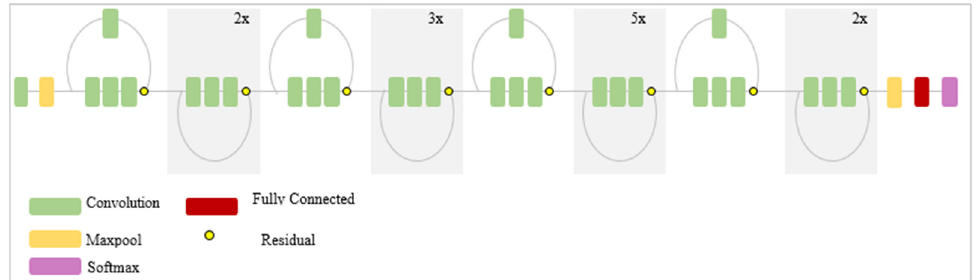
Figure A3. Schematic diagram of ResNet architecture (the compressed view).